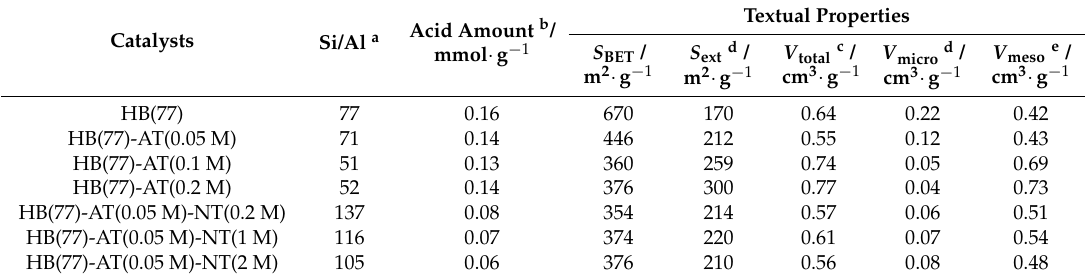
Table 2. Physicochemical properties of HB(77), alkali-treated and alkali-acid-treated catalysts.